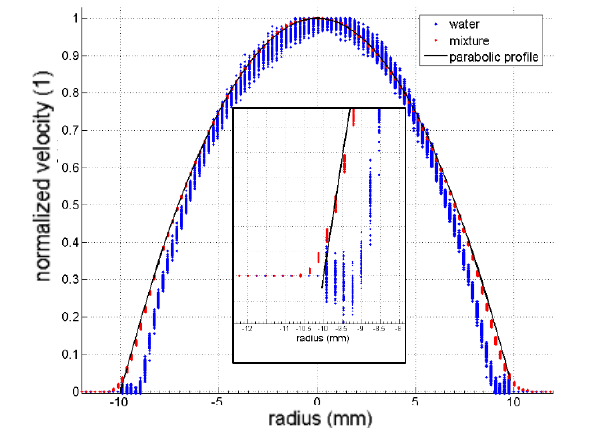
Fig. 4. Parabolic axial velocity profile in narrow section. The blue data represents data measured with water as working fluid, the red data with a mixture of water and glycerine. The black curve is obtained by analytical solution.